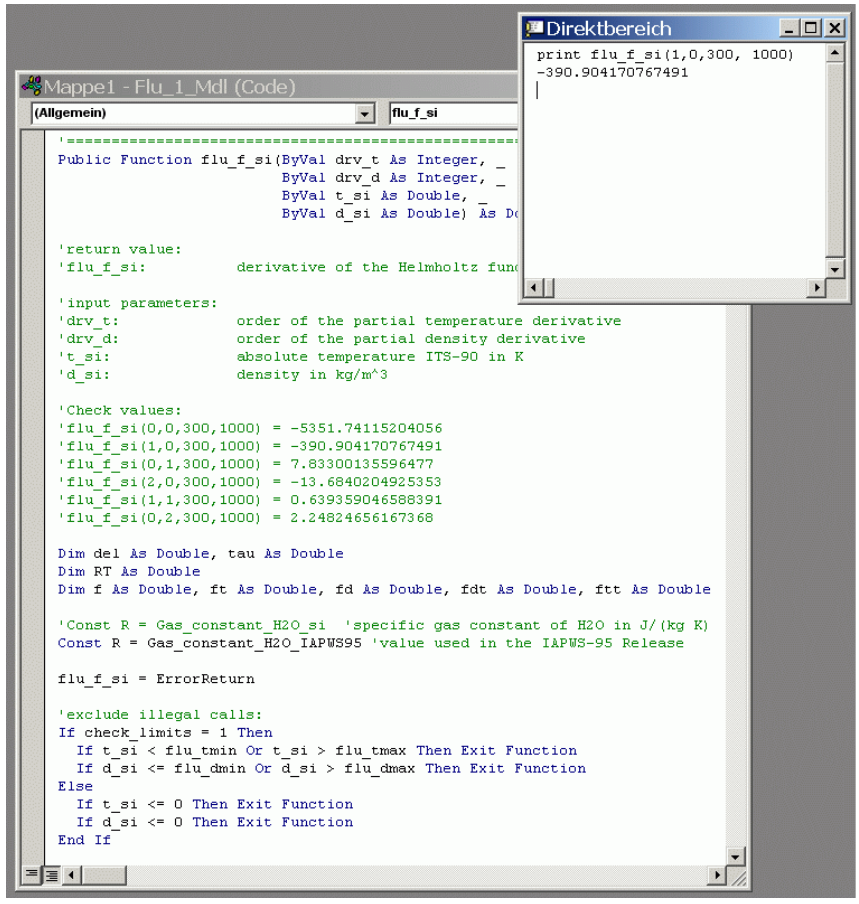
Fig. 4.2: Running the VB code within the Immediate Window of the Visual Basic Editor Fig. 3. Running the VB code within the Immediate Window of the Visual Basic Editor available in MS available in MS Excel